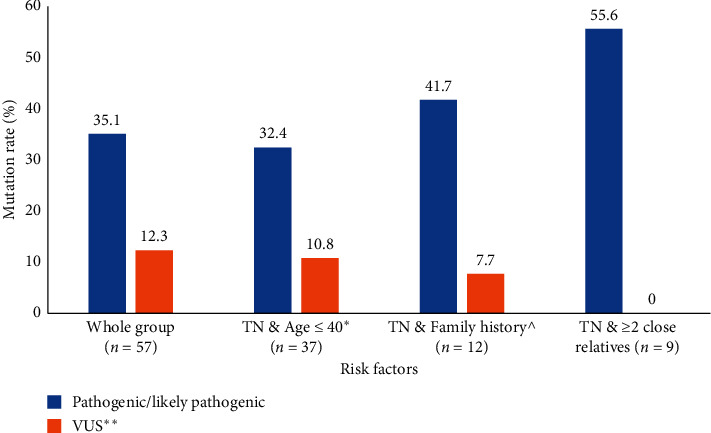

BRCA1and BRCA2 mutations among patients with triple-negatives.